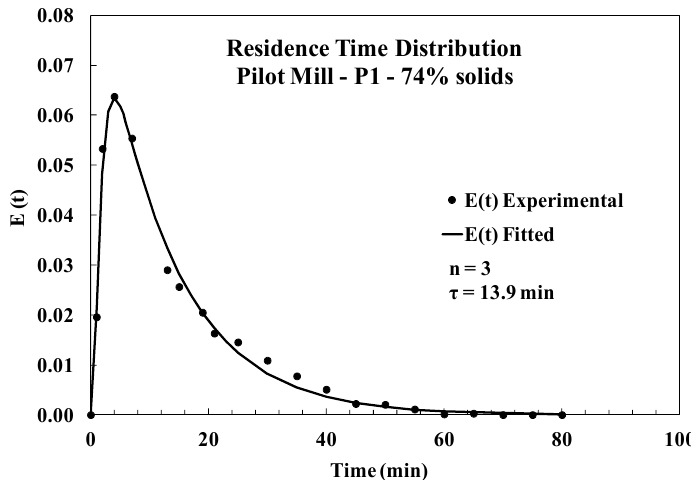
Figure 10. Comparison between experimental data and fitted residence time distribution (RTD) model for the liquid phase in pilot-scale test P1.